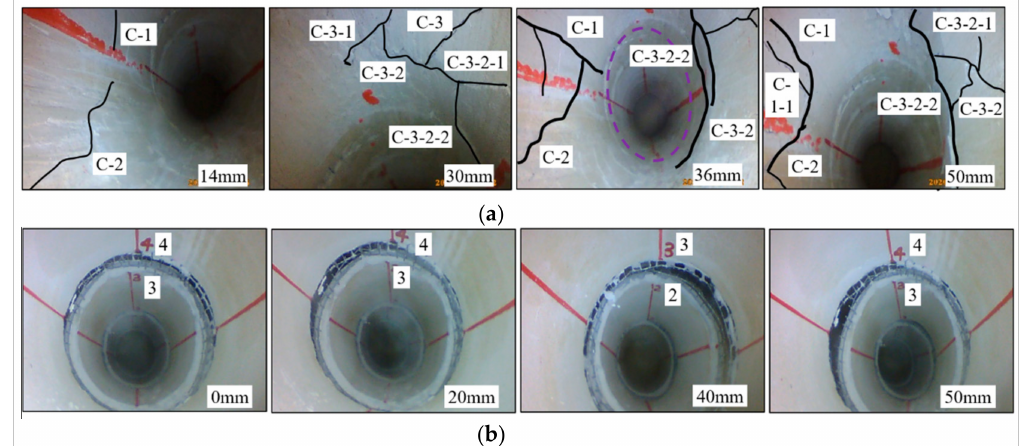
Figure 8. Deformation and cracking of the tunnel after fault dislocation. ( a ) lining without joints; ( b ) lining with joints. The lining cracks distribution of both cases 0 and 1 were plotted in Figure 9. For a tunnel without flexible joints in case 0, the cracks of the lining are mainly focused on cross-sections #2 and #3. These cracks include longitudinal cracks, circular cracks, and oblique cracks. The damage pattern in lining without joints is the combination of shear and bending damage, and the lining damage is concentrated in the fault zone. The tunnel damage range is 4 W f in case 0. For a tunnel with flexible joints in case 1, the lining cracks mainly appear on the lining segment #3. Therefore, lining segment #3 in the fault zone suffers serious damage. The tunnel damage range is 2.1 W f in case 1, and the damage range in lining with flexible joints is reduced by 48% compared to the damage range in the lining without joints.